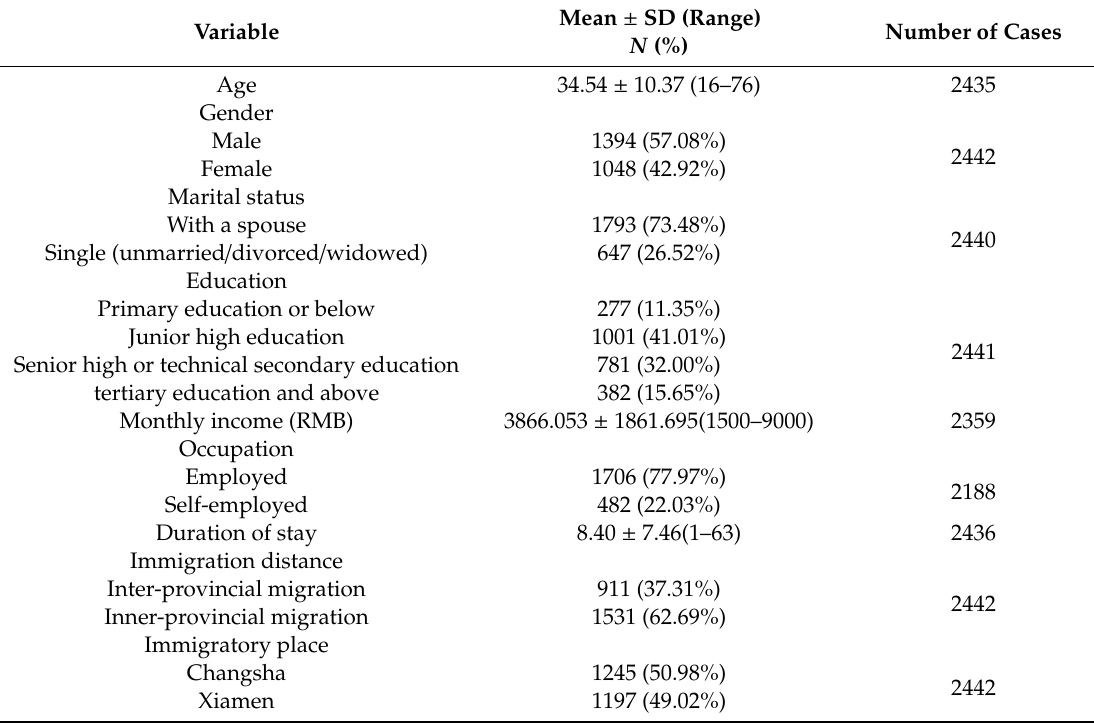
Table 1. Personal information about the